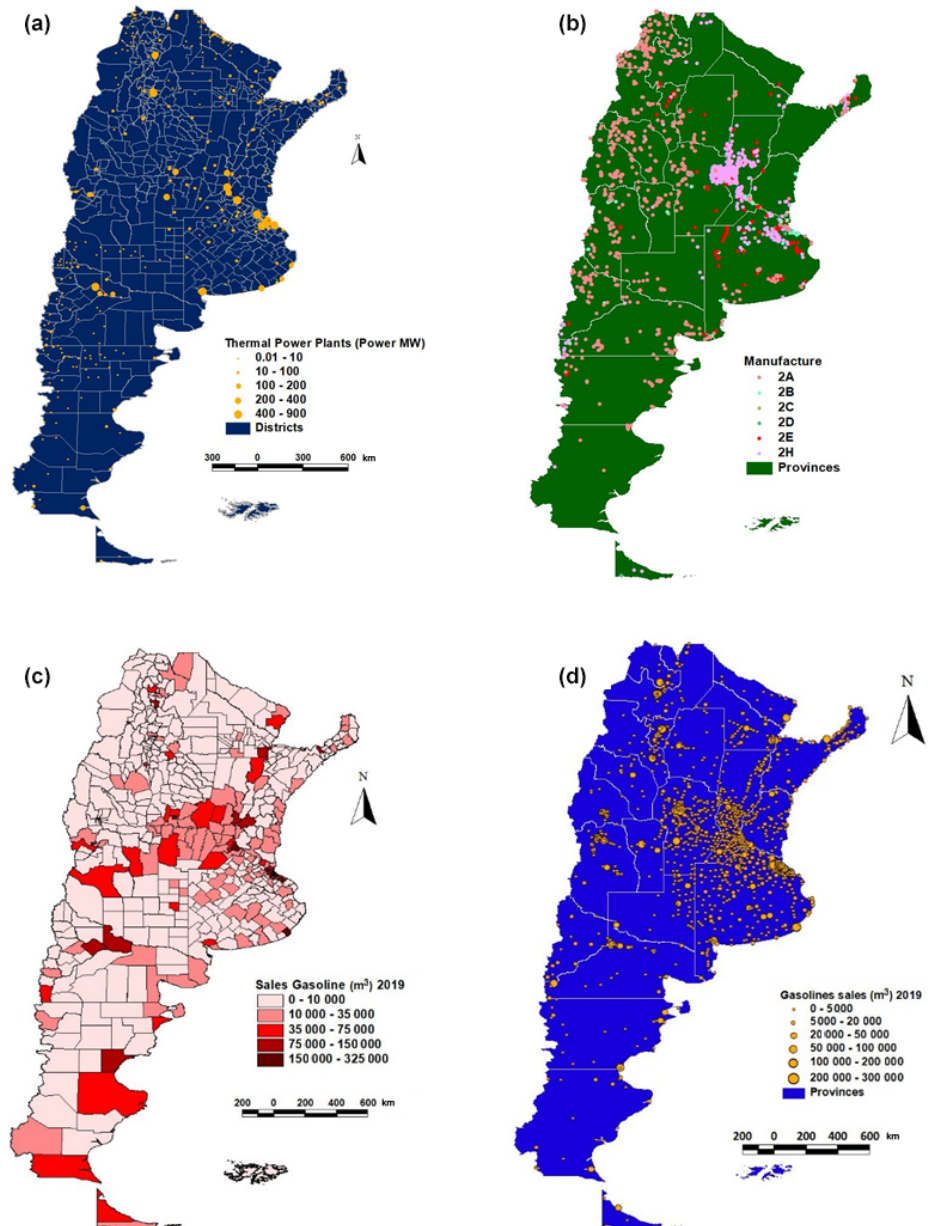
Figure 2. Location of point sources. (a) Thermal power plants (districts in white outline). (b) Manufacturing industries (provinces in white outline). Manuf. code. 2A: cement, calcium, glass, mining; 2B: chemical; 2C: steel, iron, aluminum; 2D: car-painting; 2E: other non- specified, 2H: paper, food, beverages (see Table A3). (c) District distribution of annual gasoline sales for 2019. (d) Location of refueling gas stations and their individual yearly gasoline